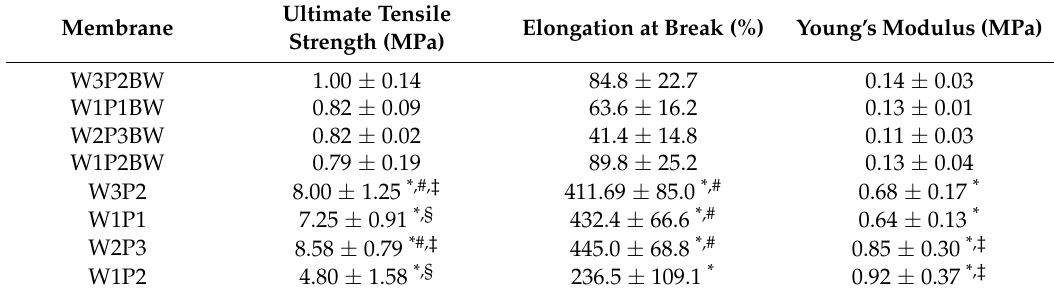
Table 2. The ultimate tensile strength, elongation percentage at break, and Young’s modulus of NFMs with different volume WPU/PEO ratios before and after the PBS treatment (BW stands for “before wash”; W3P2BW means W3P2 before washing; and W3P2 indicates the status after washing). After PEO removal through the PBS treatment, the mechanical properties of all WPU NFMs were improved. Ultimate Tensile Membrane Elongation at Break (%) Young’s Modulus (MPa) Strength (MPa) W3P2BW 1.00 ± 0.14